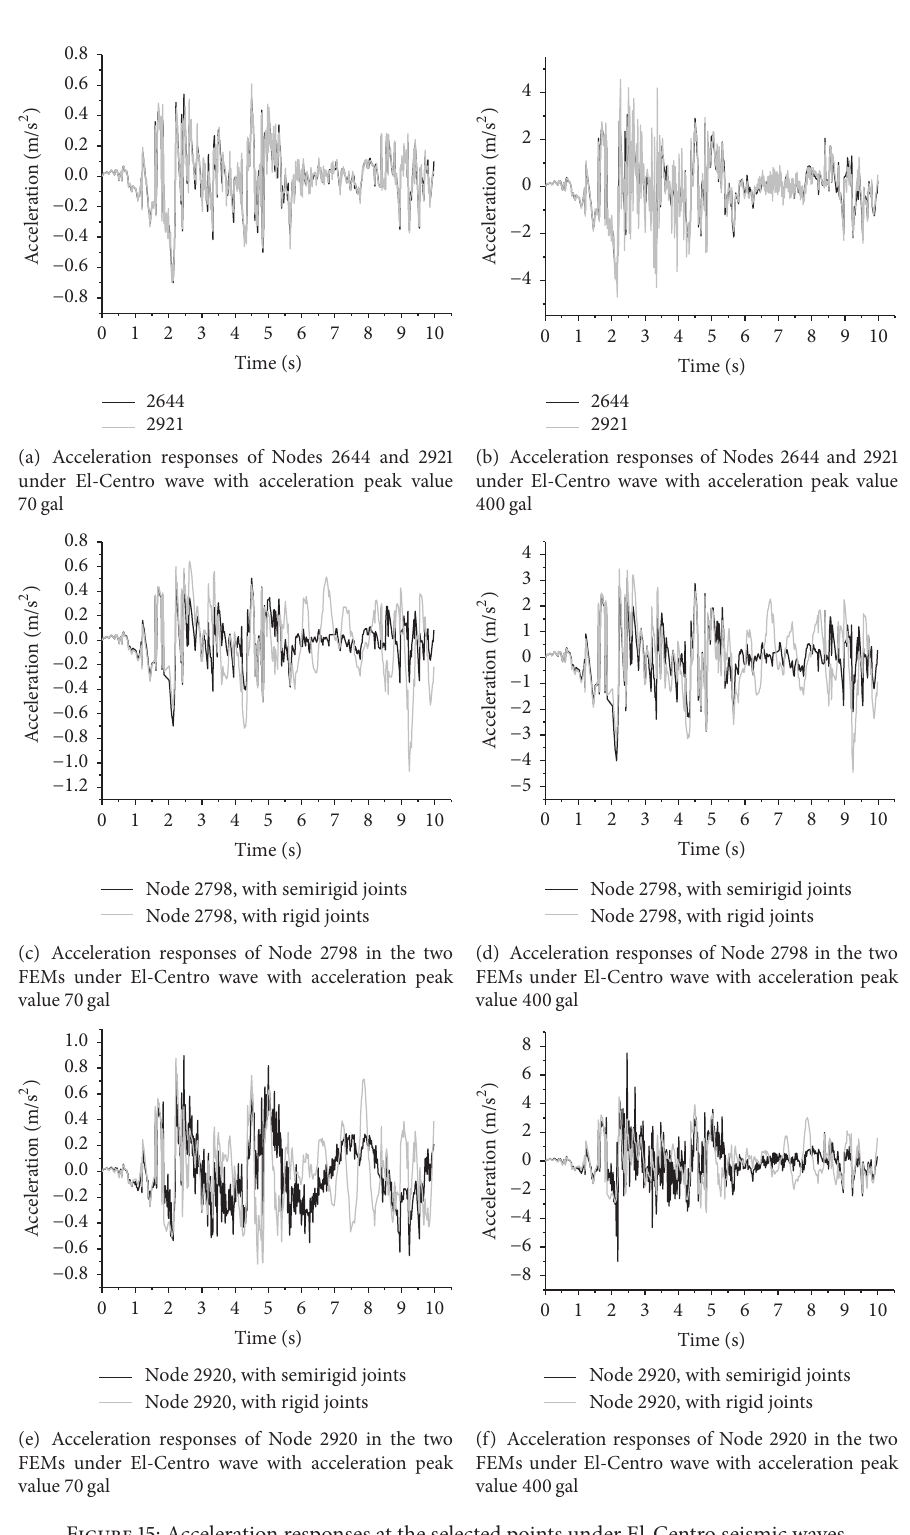
Figure 15: Acceleration responses at the selected points under El-Centro seismic